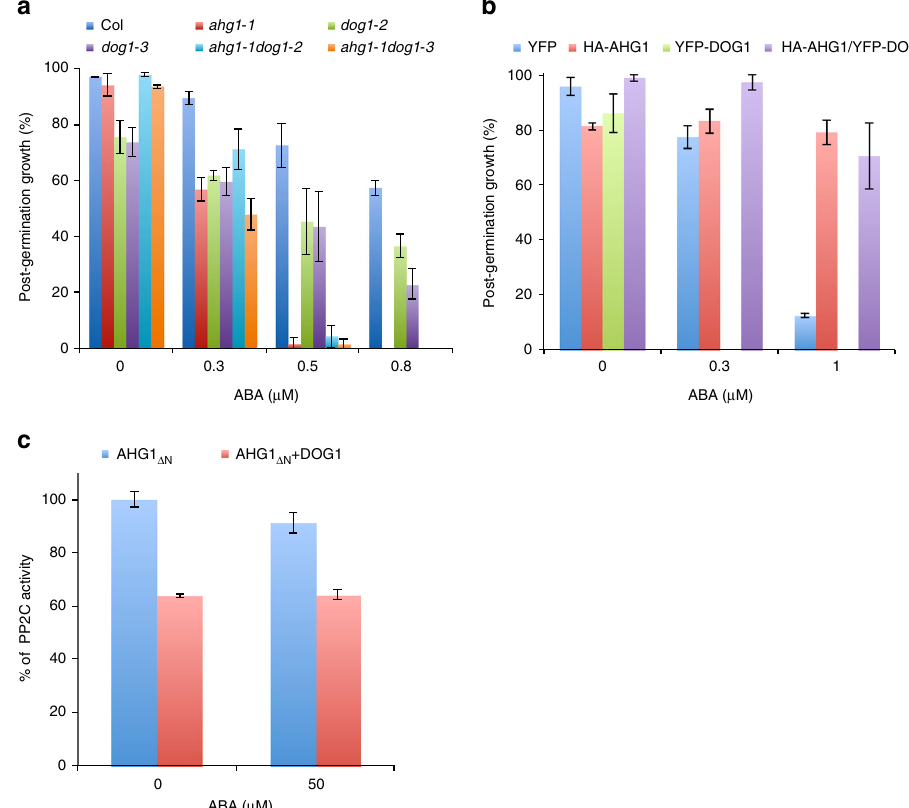
Fig. 5 Genetic and functional interactions between AHG1 and DOG1. a Post-germination growth ef fi ciencies of the single and double mutant lines ( ahg1-1 , dog1-2 , dog1-3 , ahg1-1dog1-2 , and ahg1-1dog1-3 ) and wild-type were examined in the presence of various concentrations of ABA at 7 days after strati fi cation. b Post-germination growth ef fi ciencies of the double overexpressing (HA-AHG1ox/YFP-DOG1ox), parental (HA-AHG1ox and YFP-DOG1ox), and control YFP lines were examined in the presence of various concentrations of ABA at 7 days after strati fi cation. Error bars show s.d. of three independent experiments using the same seed batch ( a , b ). c The PP2C activities of the truncated AHG1 Δ N were measured with or without DOG1 or ABA using the synthetic phosphopeptide, corresponding to the regulatory phosphorylation site of SnRK2s (HSQPK(pS)TVGTP) as a substrate. Error bars show s.d.